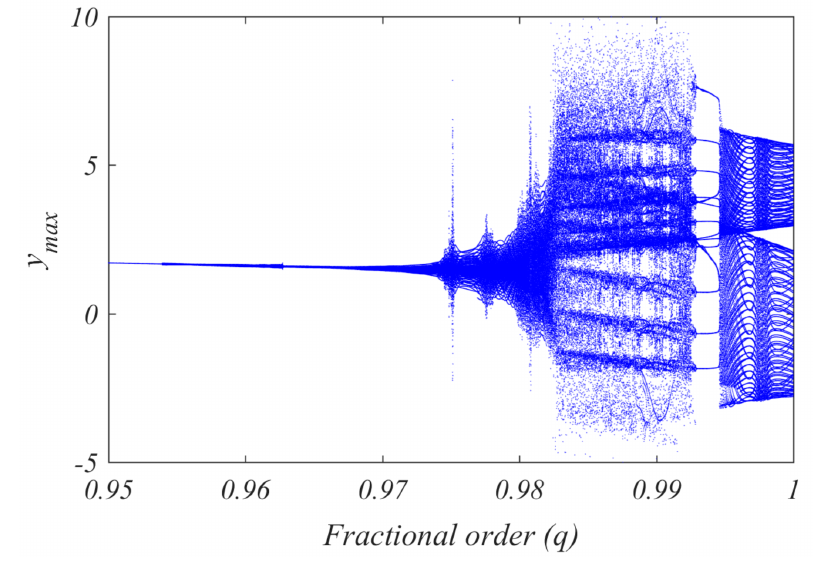
Figure 4. The bifurcation diagram verses the system fractional order ( q